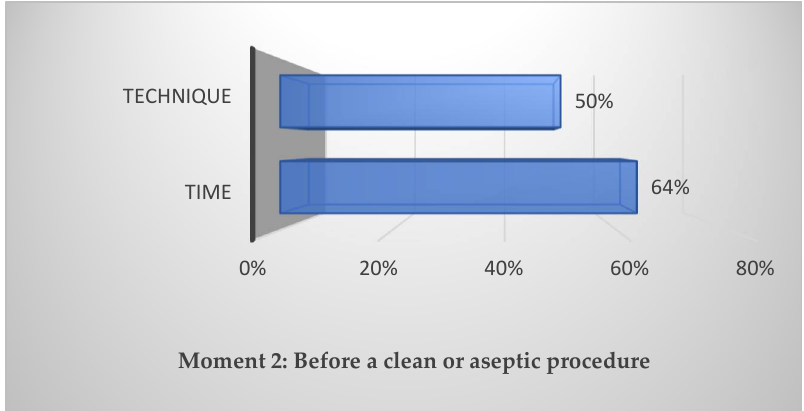
Figure 2. Adherence to hand hygiene before a clean or aseptic procedure (moment 2).